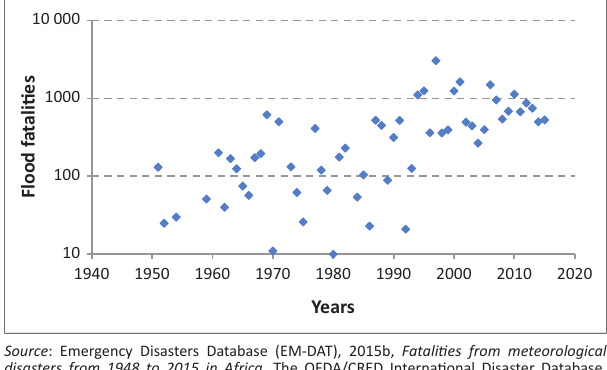
FIGURE 1: Statistics of fatalities by flood disaster events from 1950 to 2015 in